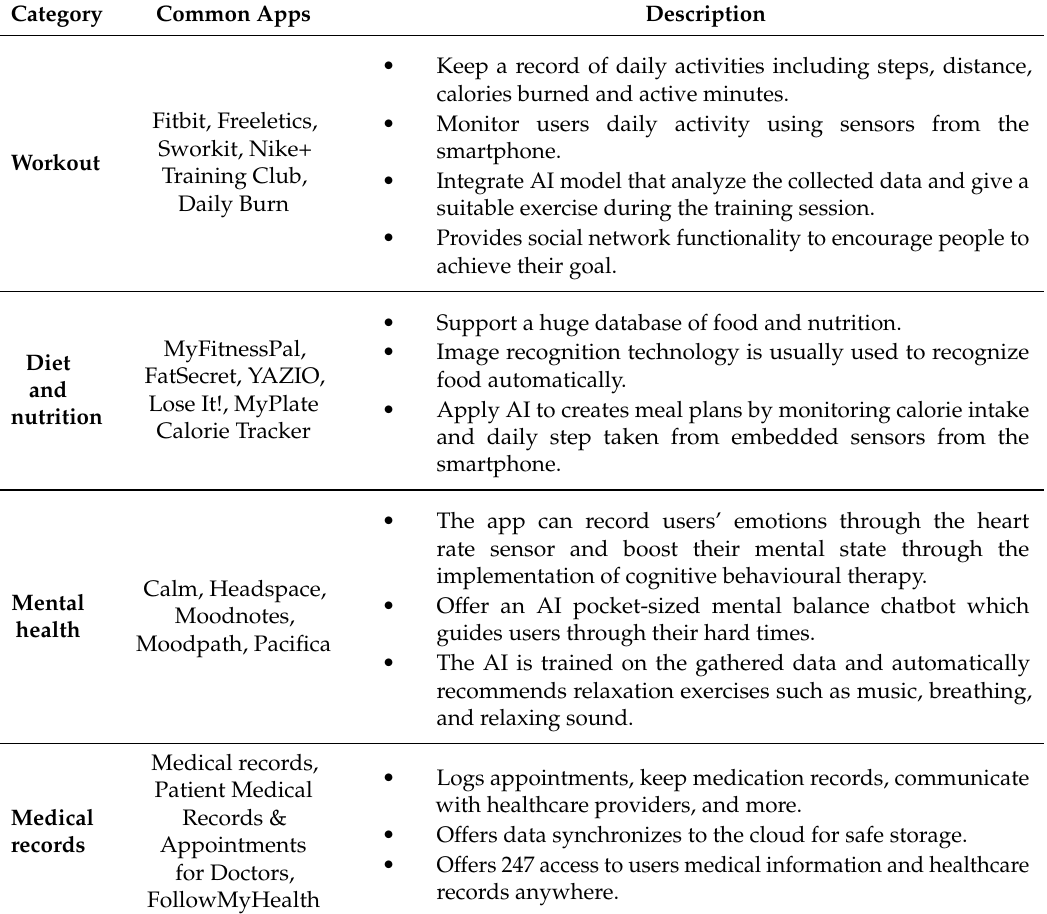
Table 9. Classification of healthcare apps for normal purpose by category and a description for each